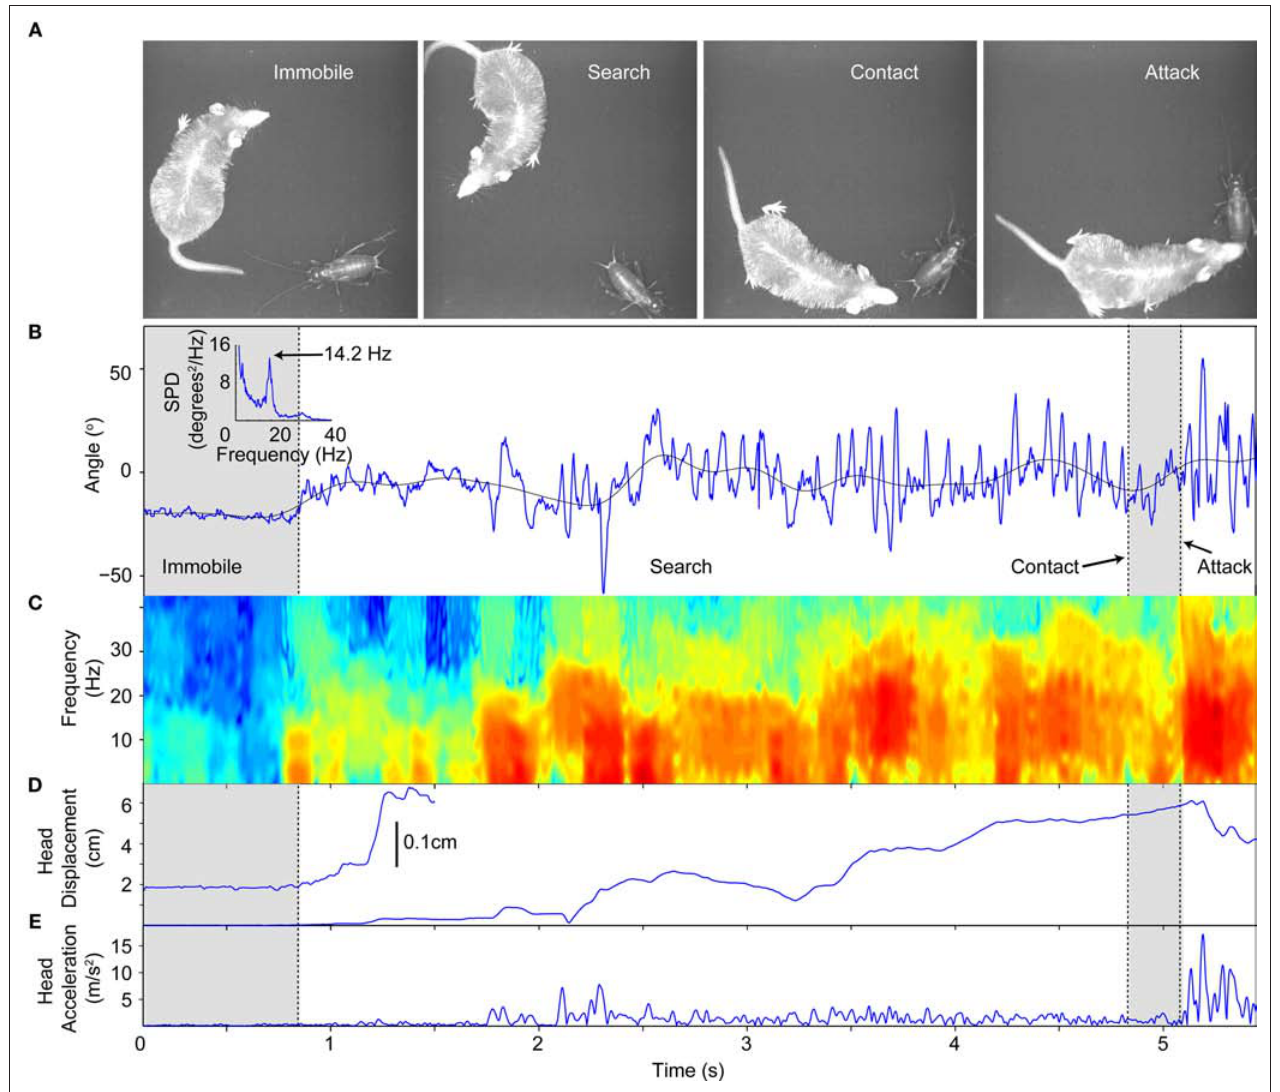
FigurE 3 | An example hunting scene. (A) Sequence of pictures taken from a hunting scene in the 9 × 9 cm arena. The pictures have been filtered to increase contrast and brightness. In each frame, the names of the phases are given from which the pictures were taken. (B) Whisker motion for a hunting trial, classified according to behavior. Black line is the whisker set angle. Inset is the average power spectrum prior to the attack. (C) Spectrogram of whisker motion. During the search phase there is an